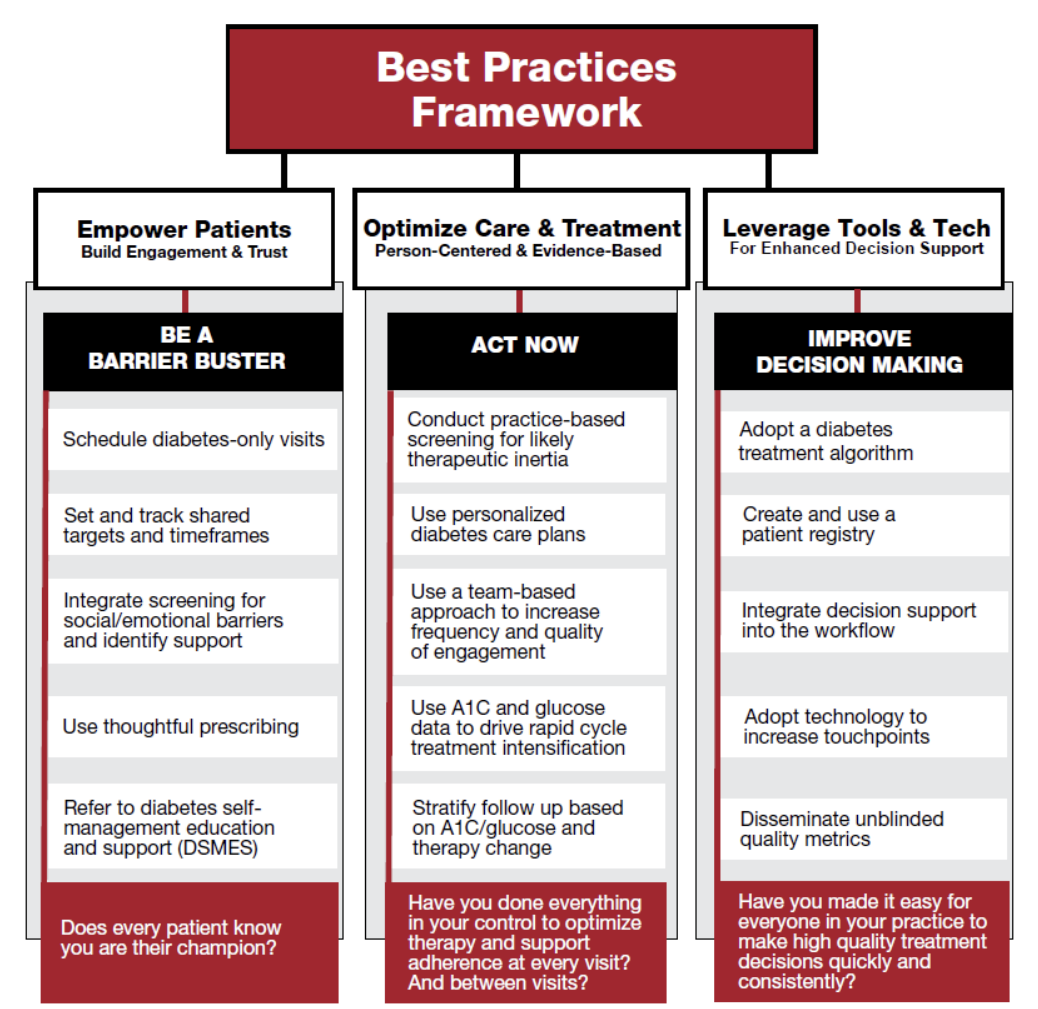
Figure 3. OTI initiative best clinical practices. Methods for avoiding clinical inertia based on the ADA’s OTI Initiative. These action-based recommendations are evidence- and consensus-based on real practice experiences. Reprinted with permission from Gabbay et al. [18].